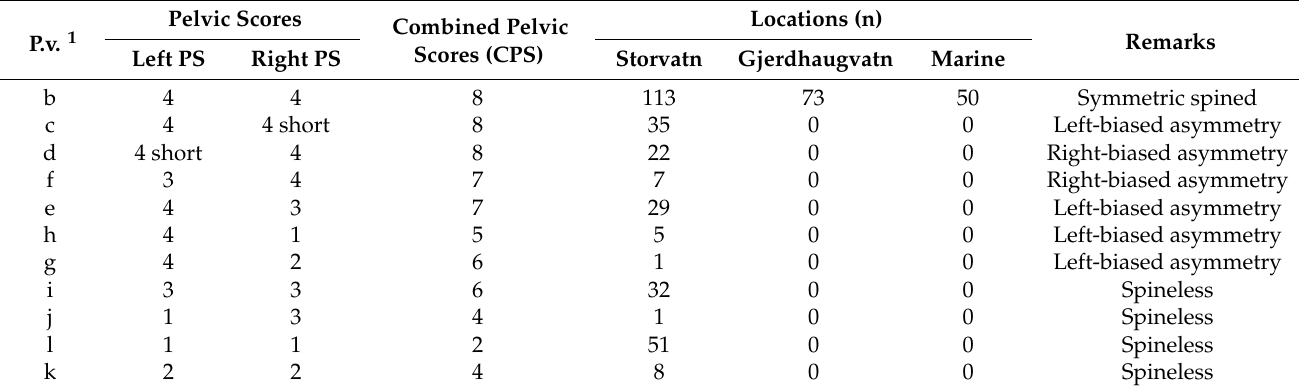
Table 2. Number of morphological variants from the three examined populations, Lake Storvatnet, Lake Gjerdhaugvatnet and the marine site. See also Supplementary Figure S1. “n” is the number of each morphological variant from each location. 1 The left column (‘’P.v.”) refers to the pelvic spine morphs as shown in the Supplementary Figure